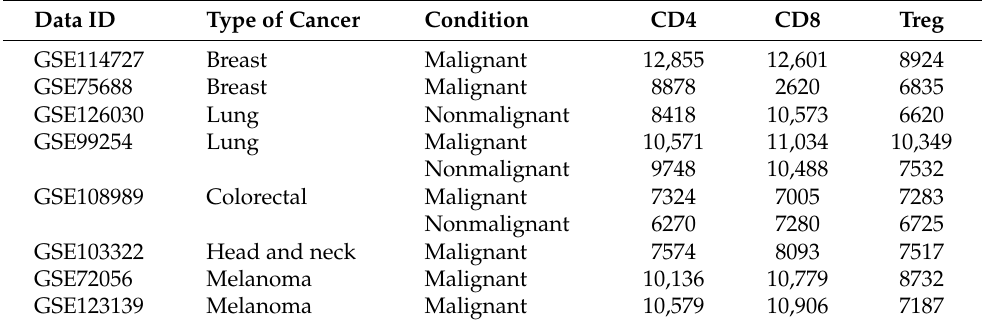
Table 1. Summary of the datasets used in this work. Each row indicates the number of genes for CD4-T, CD8-T and Treg cells.